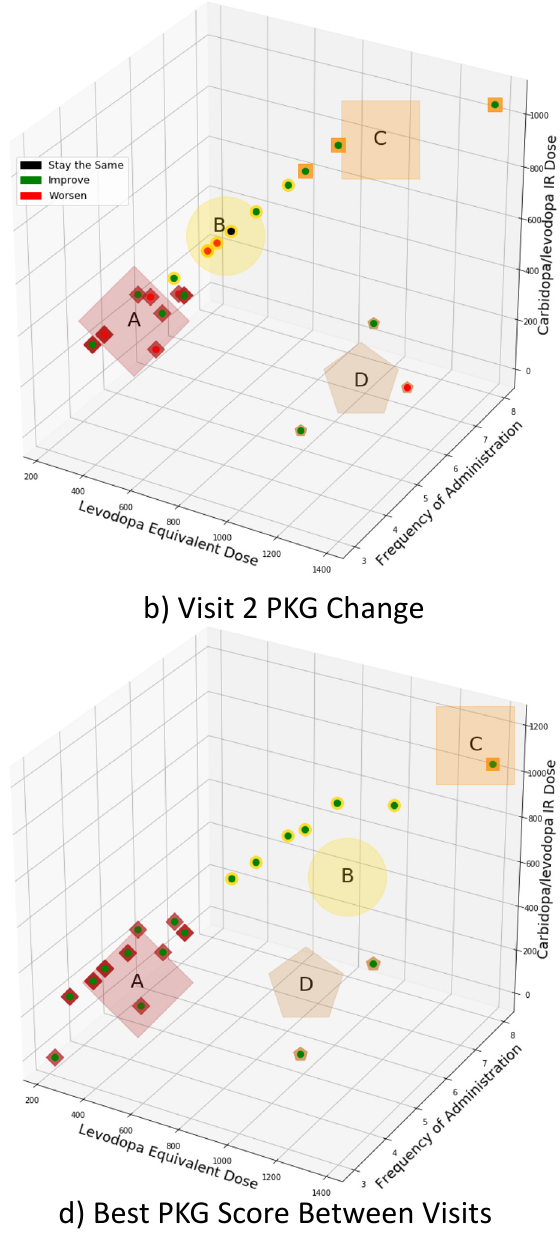
Figure 3. ( a , b ) demonstrates the clusters for the motor function changes between visit 1 to visit 2 based on the MDS- UPDRS-III scores and the PKG’s summary dyskinesia and bradykinesia scores, respectively. ( c , d ) highlight the subjects’ best symptom control recorded using MDS-UPDRS-III scores and PKG’s summary dyskinesia and bradykinesia scores, respectively. The large shapes denote each cluster’s centroid, and the exterior marker of each point corresponds to the cluster centroid shape. The capital letters (A–D) are used to refer to each cluster. Each point’s interior maker in ( a , b ) represents the state of MDS-UPDRS-III and PKG change for each patient, where a black interior-point denotes the patient stayed the same between visits, a green point denotes that the patient’s visit 2 scores were better than their visit 1 scores. A red point denotes that the patient’s visit 2 scores were worse than their visit 1 scores. Note that due to the three-dimensional projection of the plot, the distance between points may appear skewed. See Supplemental Information for a 3-D animation showcasing the clusters’ position in space.